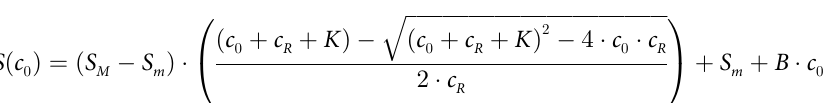
S3 Fig. Identification of the IIIG5 epitope within the RC γ chain. (A ) Fragmentation